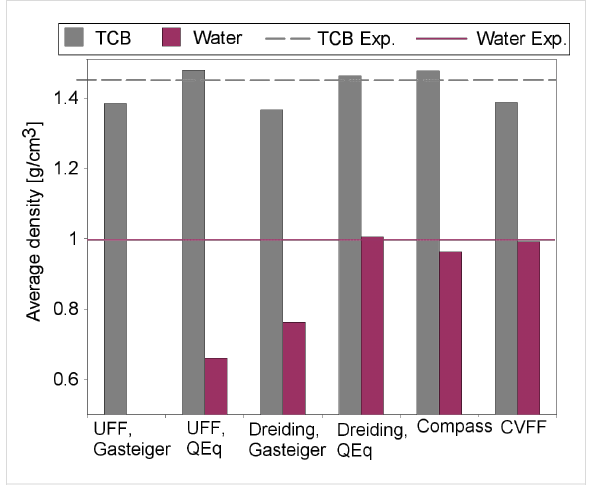
Figure 3: Force-field molecular dynamics densities of water and TCB at 298 K. Experimental values for water are taken from [33] and for TCB from